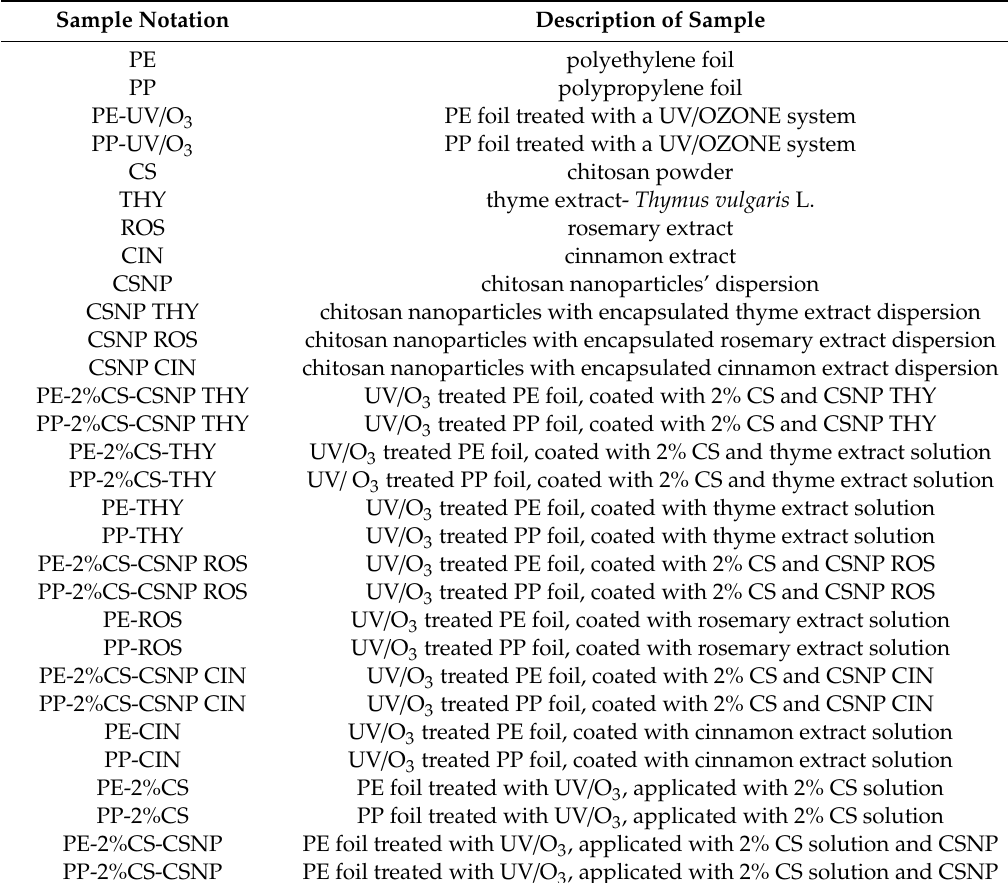
Table 11. Sample